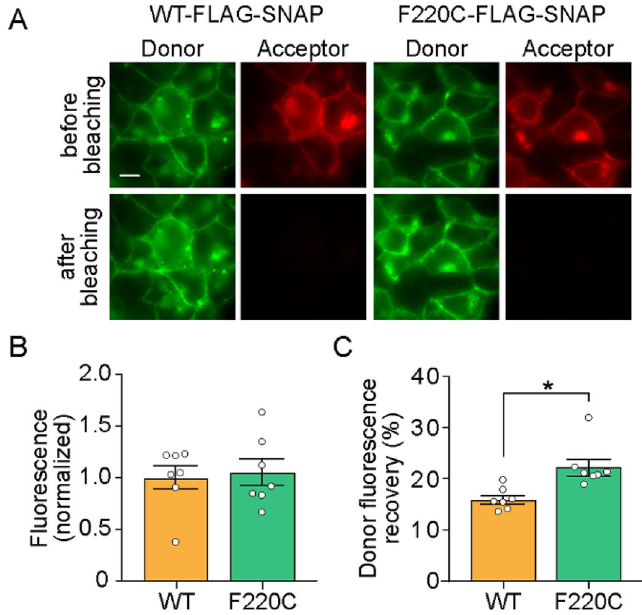
Figure 10. Distinct dimer conformations of WT and F220C opsins in the plasma membrane of HEK293 cells. (A) Fluorescence images of HEK293 cells expressing WT-FLAG-SNAP opsin and F220C-FLAG-SNAP opsin labeled with SNAP donor (BG-JF 549 ) and acceptor (BG-JF 646 ) dyes. The top and bottom rows show images of cells taken before and after bleaching of the acceptor by high intensity 640 nm illumination. Scale bar, 10 μm. (B) Summary of acceptor fluorescence as a reporter of comparable surface expression for both constructs. (C) Summary of donor fluorescence recovery upon acceptor bleaching, indicative of FRET (*, p = 0.007, unpaired t-test